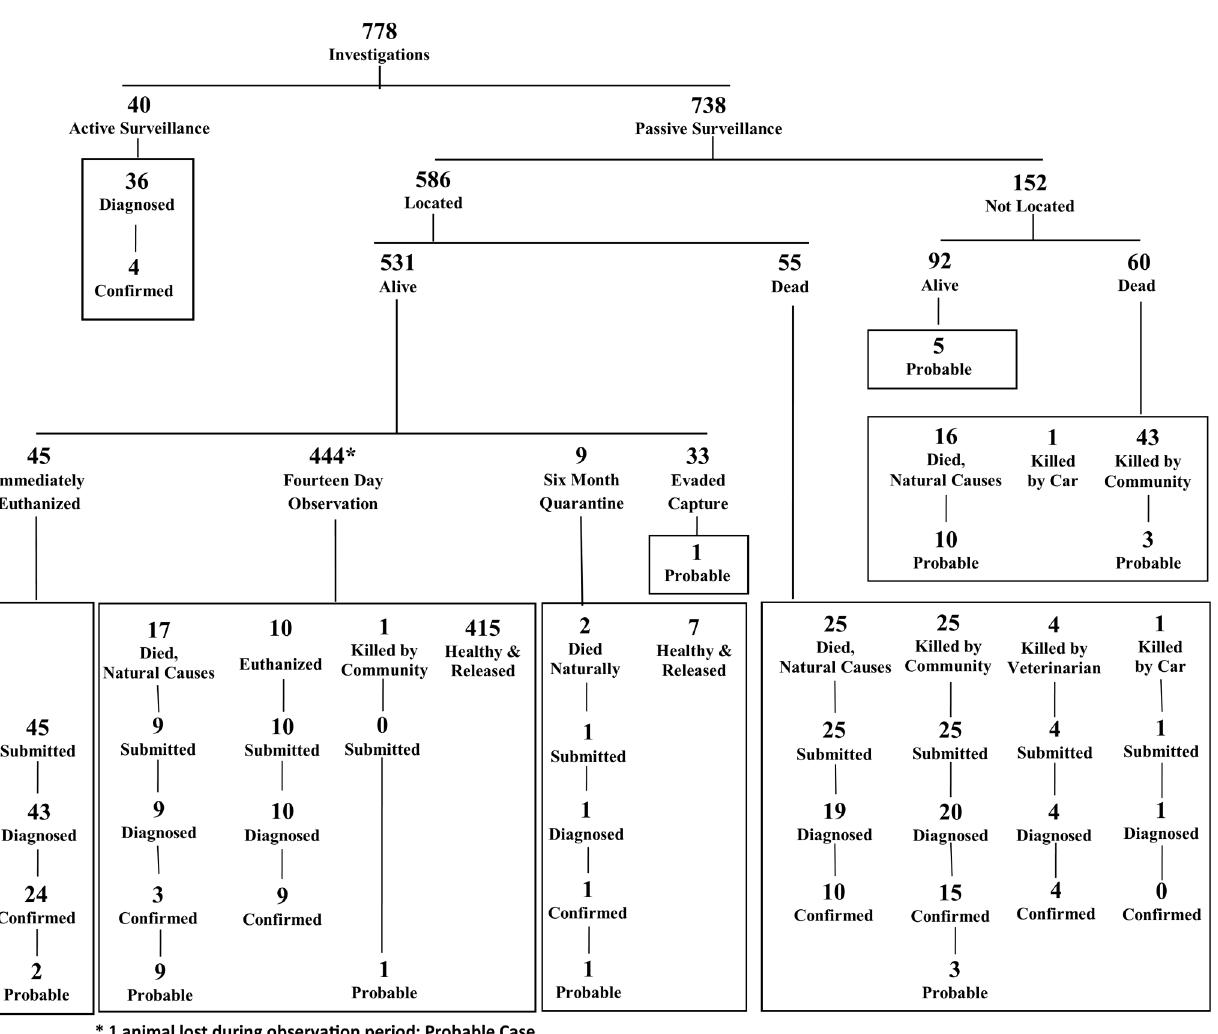
Fig 2. Outcomes of investigations and diagnosis of animals investigated through the Haiti Animal Rabies Surveillance Program, Haiti January 2013 – December